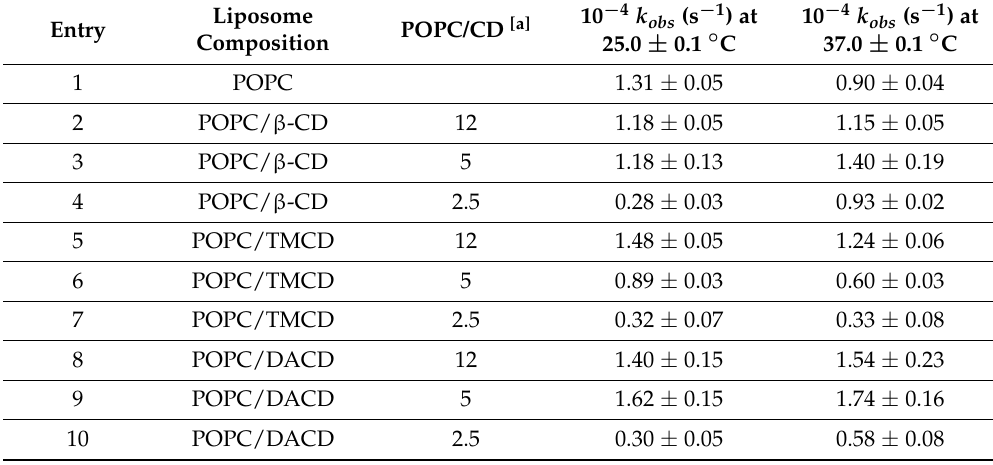
Table 3. First-order rate constants for the release of carboxyfluorescein (CF 3 − ) from pure and CD-doped POPC